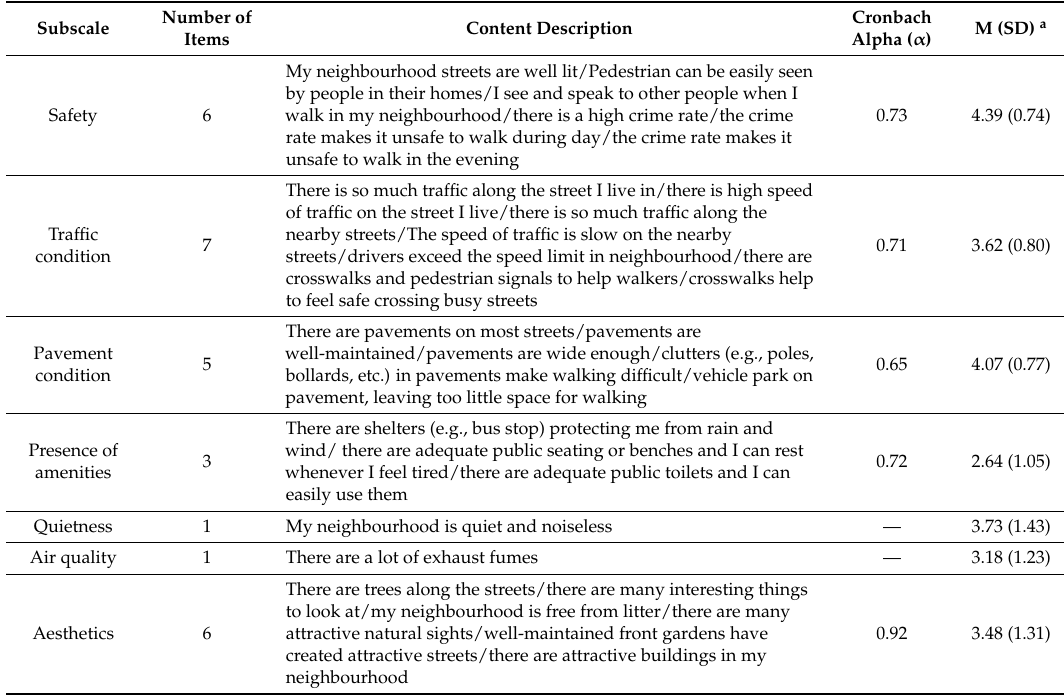
Table 2. Description of subscales of the